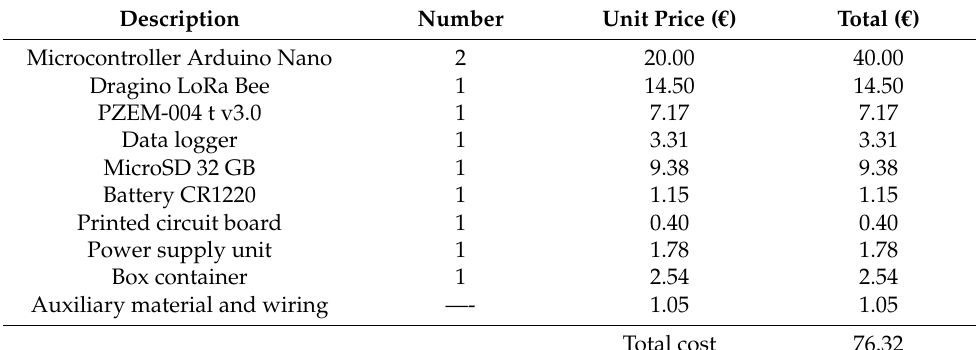
Table 6. Cost of the components for an EVMDHL with a battery power supply.